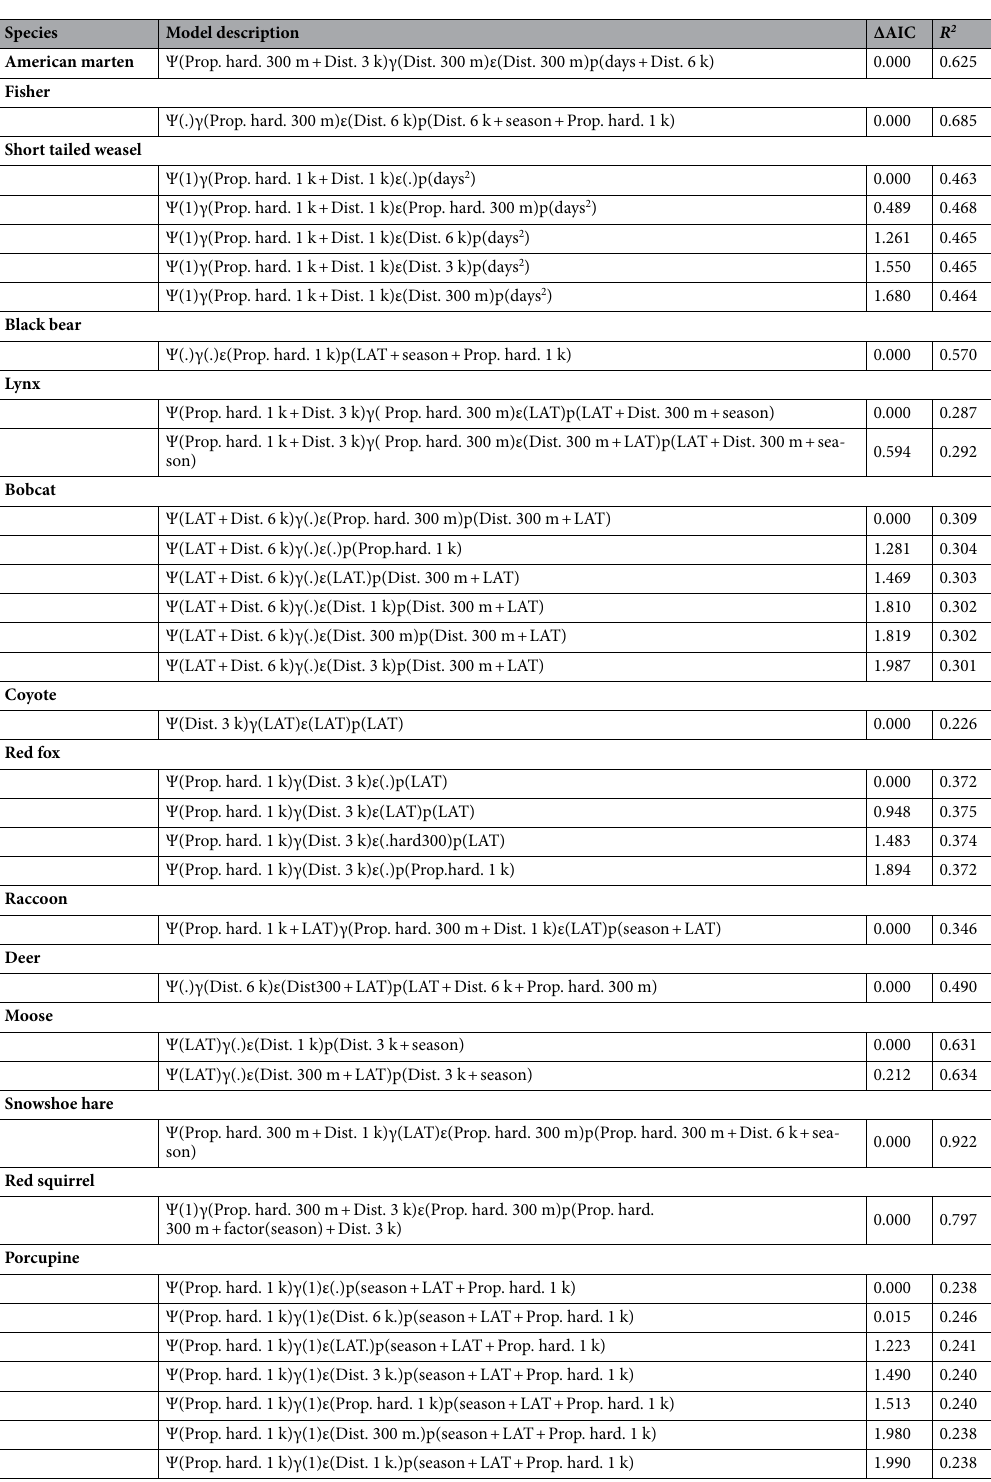
Table 1. Ranking of multi-season occupancy models within 2 ΔAIC of the top model for all 14 species. Detection data were collected over four years at 197 camera trap stations in Maine, USA. Prop. hard. 300 m = proportion of hardwood within a 300 m radius buffer of the site; Prop. hard. 1 k = proportion of hardwood within 1 k of the site; Dist. 300 m = Intensity of forest disturbance within 300 m of the site; Dist. 1 k = Intensity of forest disturbance within 1 k of the site; Dist. 3 k = Intensity of forest disturbance within 3 k; Dist. 6 k = Intensity of forest disturbance within 6 k of the site; LAT = latitude; days = days since start of survey at a site (days 2 = quadratic effect); season = winter or summer; ΔAIC = Delta Akaike Information Criterion; R 2 = Nagelkerke’s R